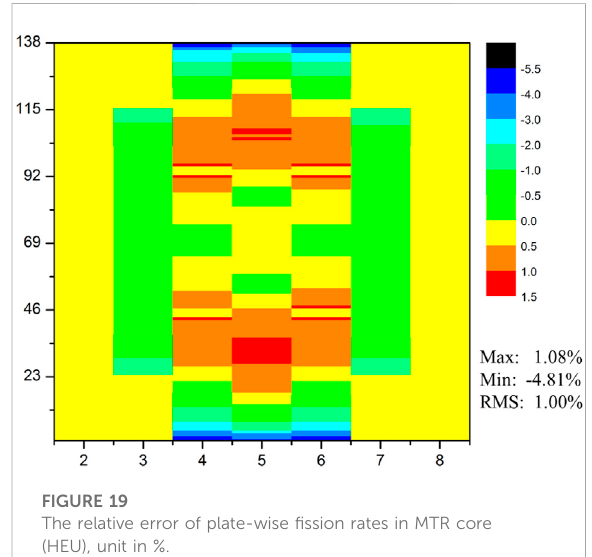
FIGURE 19 The relative error of plate-wise fi ssion rates in MTR core (HEU), unit in